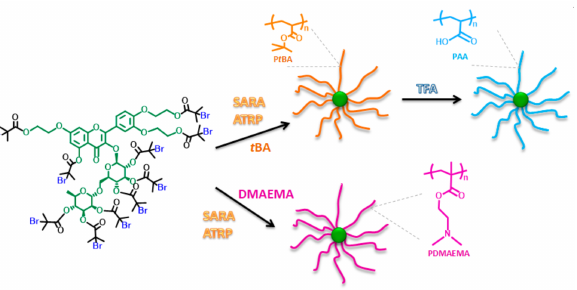
Figure 1. Synthetic route for the preparation of troxerutin-based polyelectrolytes.